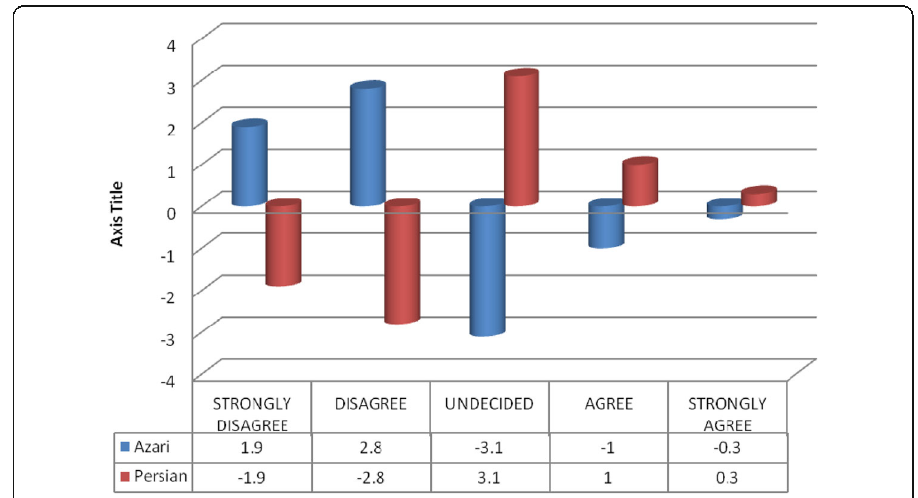
Fig. 1 standardized residuals of the perceptions towards explicit grammar instruction and corrective feedback